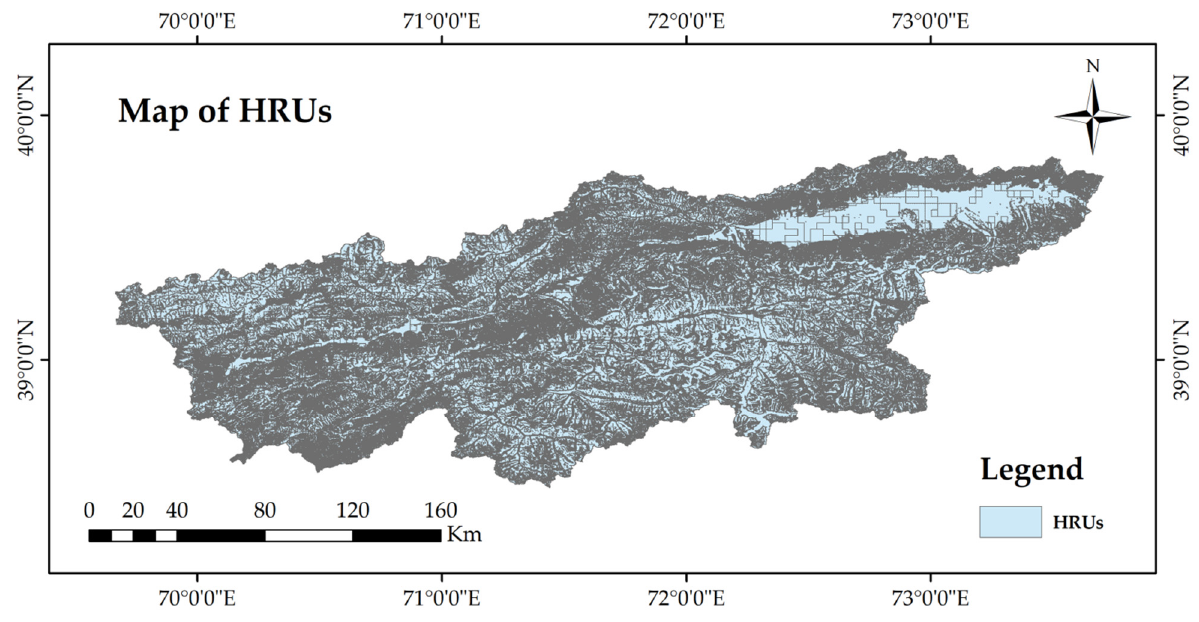
Figure 3. The map of HRUs of the Upper Vakhsh River Basin in Central Asia. HRUs: hydrologic response units. Distributed models include a large number of parameters and dealing with all these parameters at the calibration stage is not feasible. So, to ensure efficient calibration, a sensitivity analysis was conducted to filter out less influential parameters using a built-in SWAT sensitivity analysis tool. During the model calibration, the monthly observed discharge of 1979–1999 recorded at the Darband discharge station was used, which is located at the outlet of the UVRB.